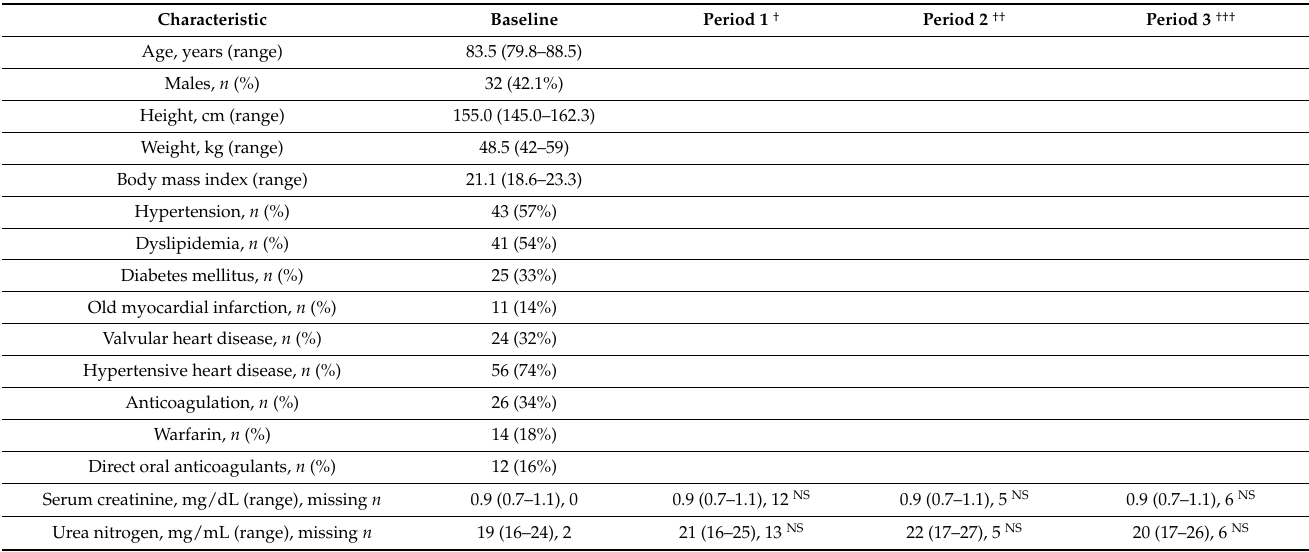
Table 1. Baseline characteristics and time course of the clinical